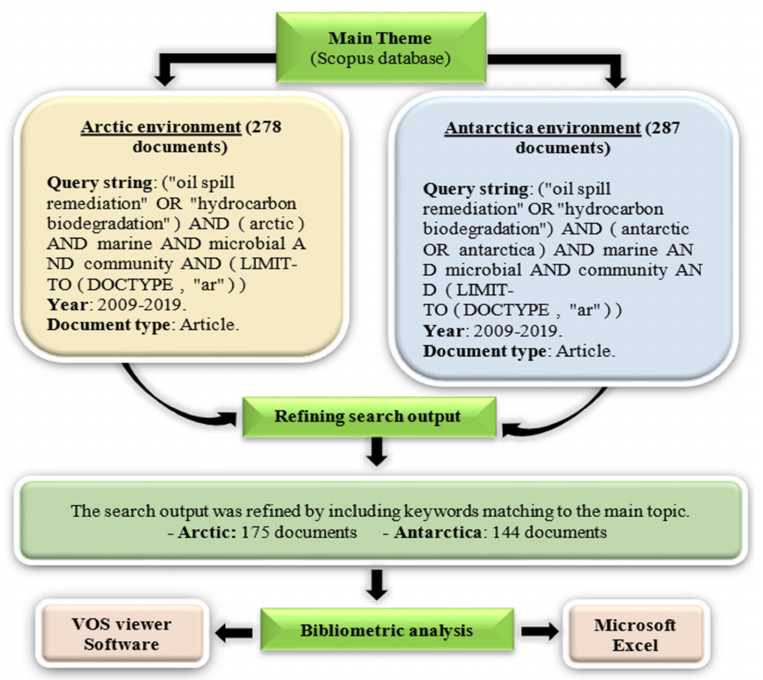
Figure 1. Flowchart of data collection of documents published in relevance to the main theme: hy- drocarbon degradation by microbial communities in both Arctic and Antarctic marine